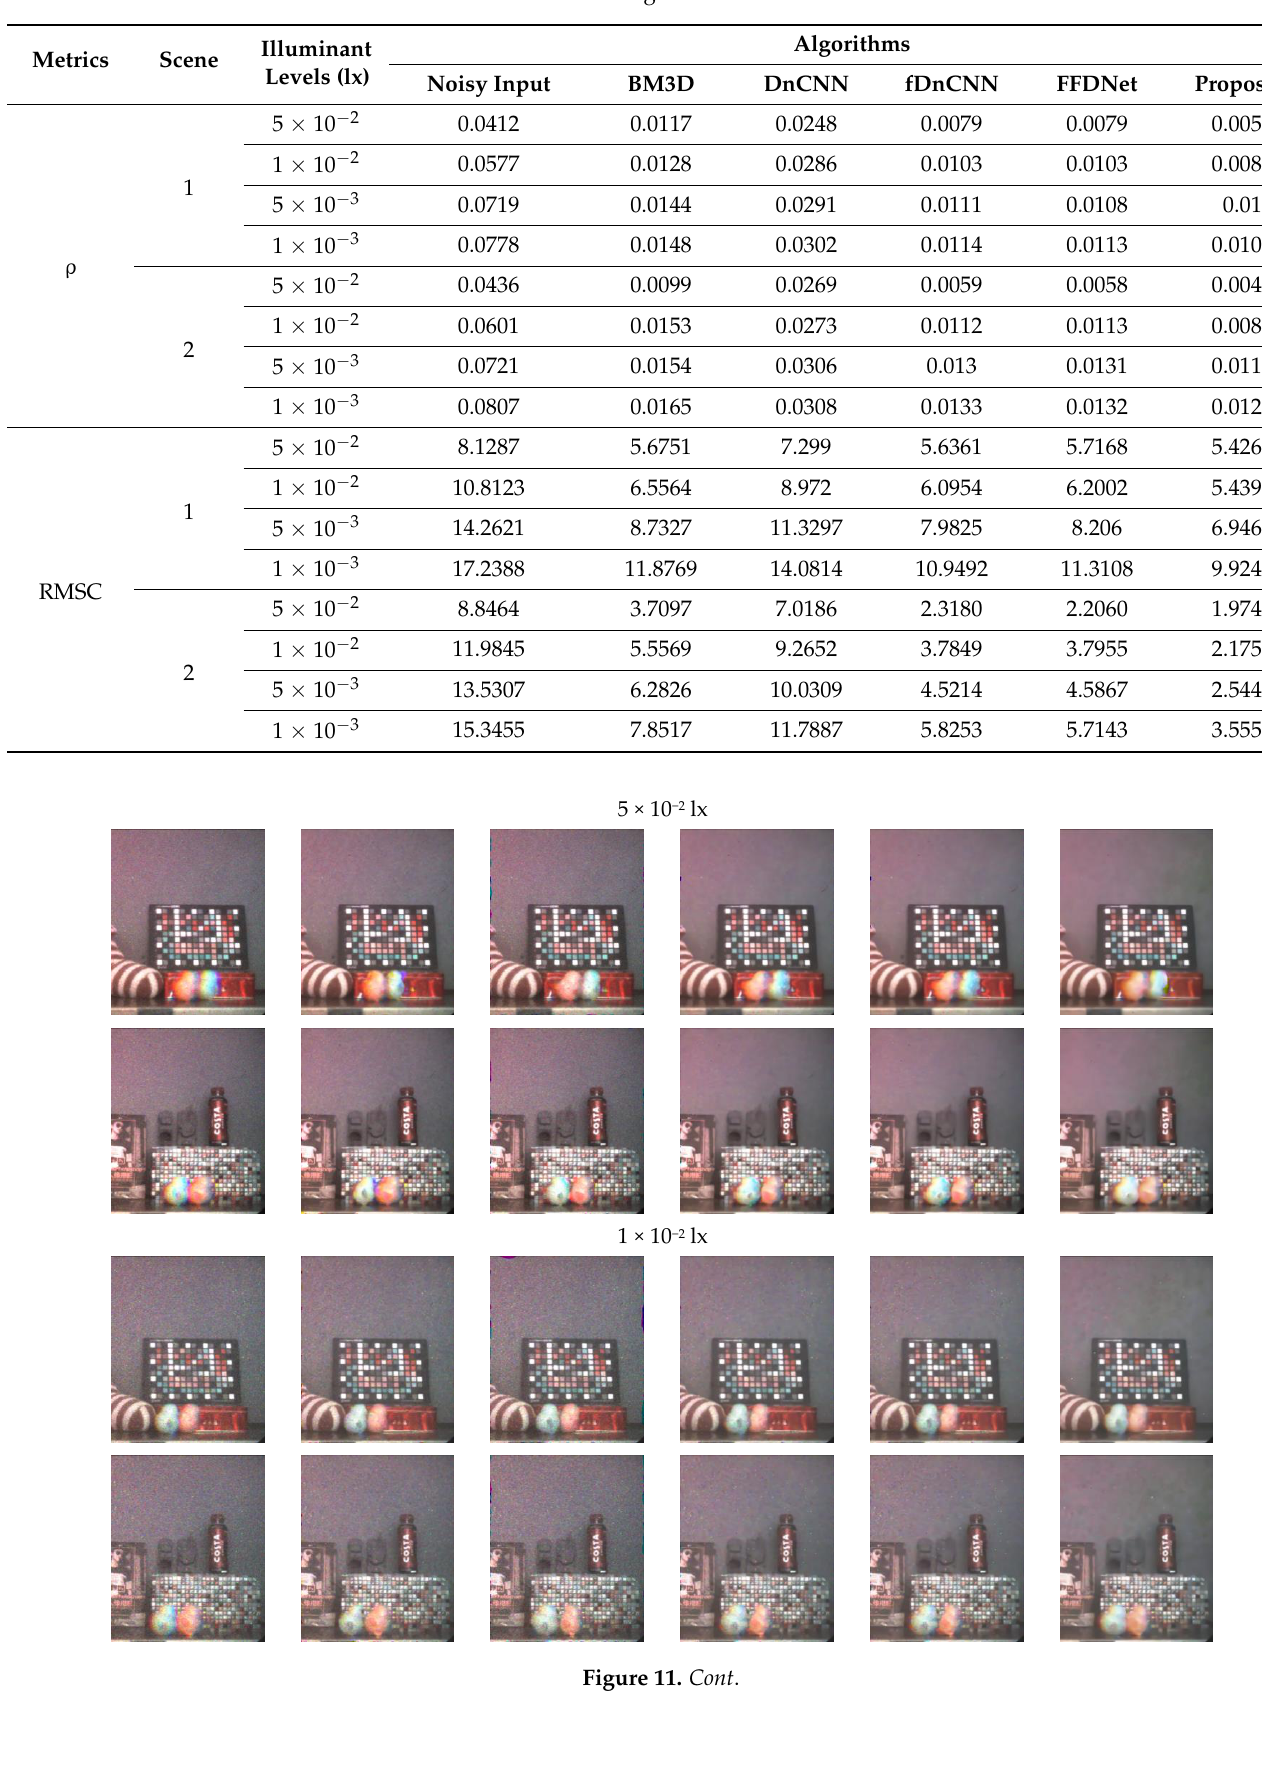
Table 4. Evaluation metrics for each algorithm under different illuminant levels.